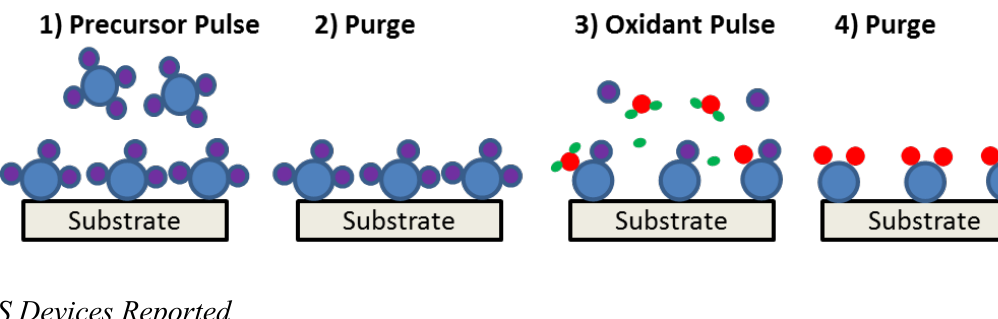
Figure 10. Schematic representation of atomic layer deposition